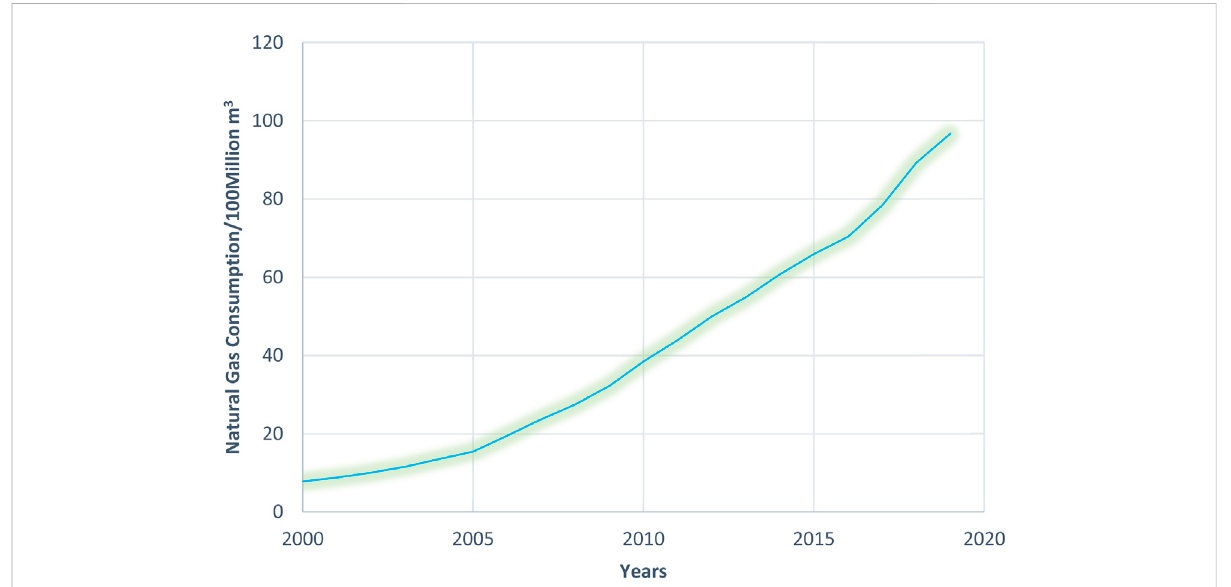
FIGURE 4 Changes in average natural gas consumption in 30 provinces from 2000 to